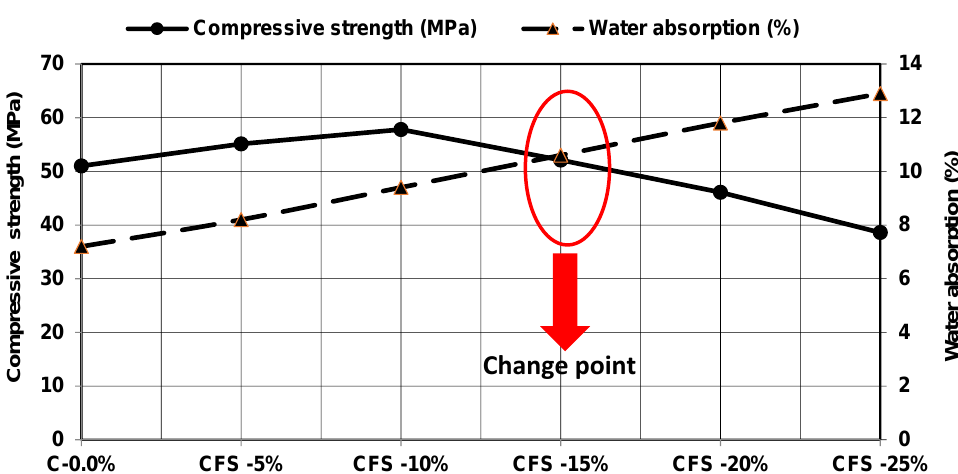
Figure 9. The relationship between compressive strength and water absorption (%) depends on the replacement percentage.